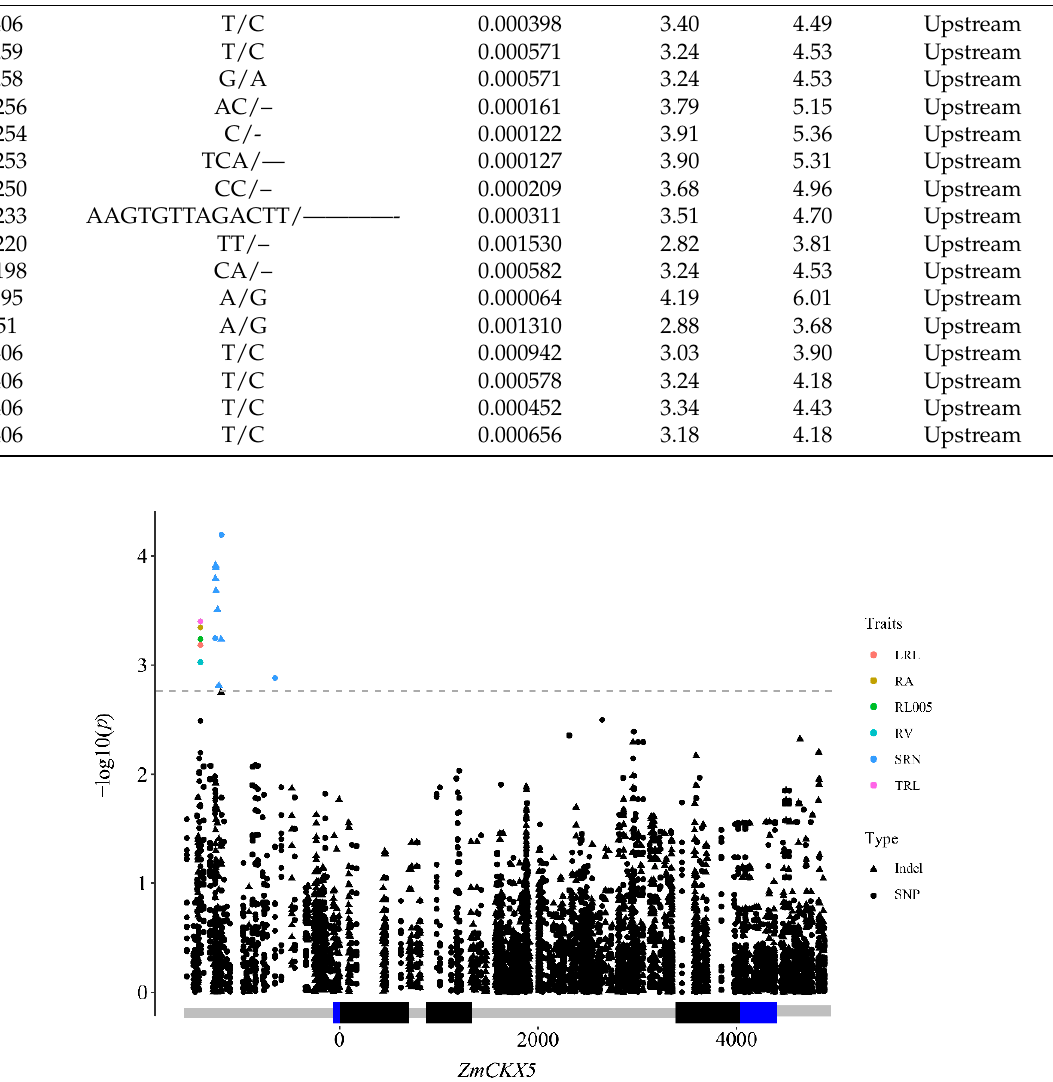
Figure 2. Association analysis between ZmCKX5 and root traits. Triangles and dots represent InDels and SNPs, respectively. Abbreviations for traits are as follows: LRL, lateral root length; RA, root surface area; RL005, root length between 0 mm and 0.5 mm in diameter (RL005); RV, root volume; SRN, seminal root number; TRL, total root length.